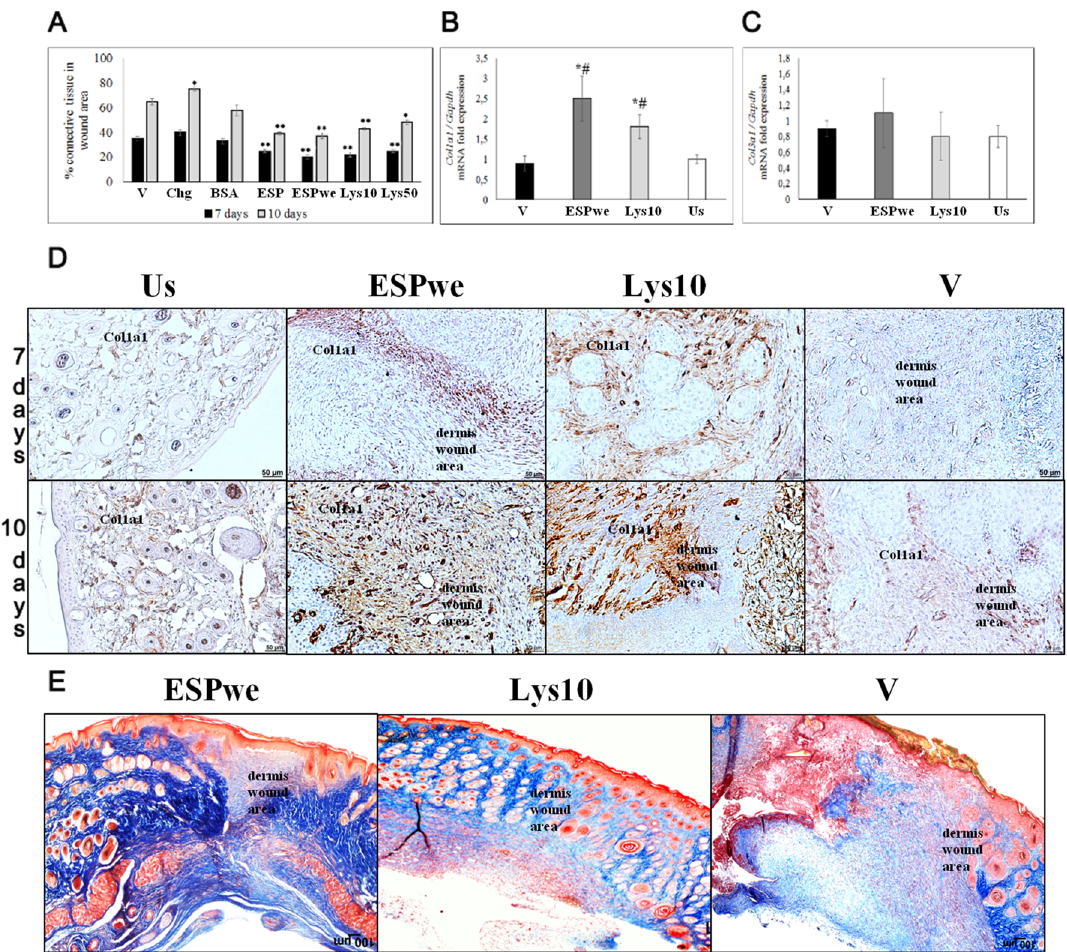
Figure 4. Skin extracellular matrix study. In all groups of specific treatment, a significant decrease of connective tissue area was detected. ( A ) Percentage of connective tissue in a wound area. V vehicle, Chg chlorhexidine, BSA bovine serum albumin, ESP excretory secretory product, ESPwe excretory secretory product without endotoxin, Lys 10 Lysate 10 µg, Lys 50 Lysate 50 µg. Data is presented as mean ± SEM, *p < 0.05; **p < 0.01 as compared to a vehicle; ( B , C ) Col1a1 , Col3a1 gene expression normalized to Gapdh gene expression. V vehicle, ESPwe excretory secretory product without endotoxin, Lys 10 Lysate 10 µg, Us unwounded healthy skin. Data is presented as mean ± SEM, *p ≤ 0.05 as compared to unwounded healthy skin group, # p ≤ 0.05 as compared to a vehicle